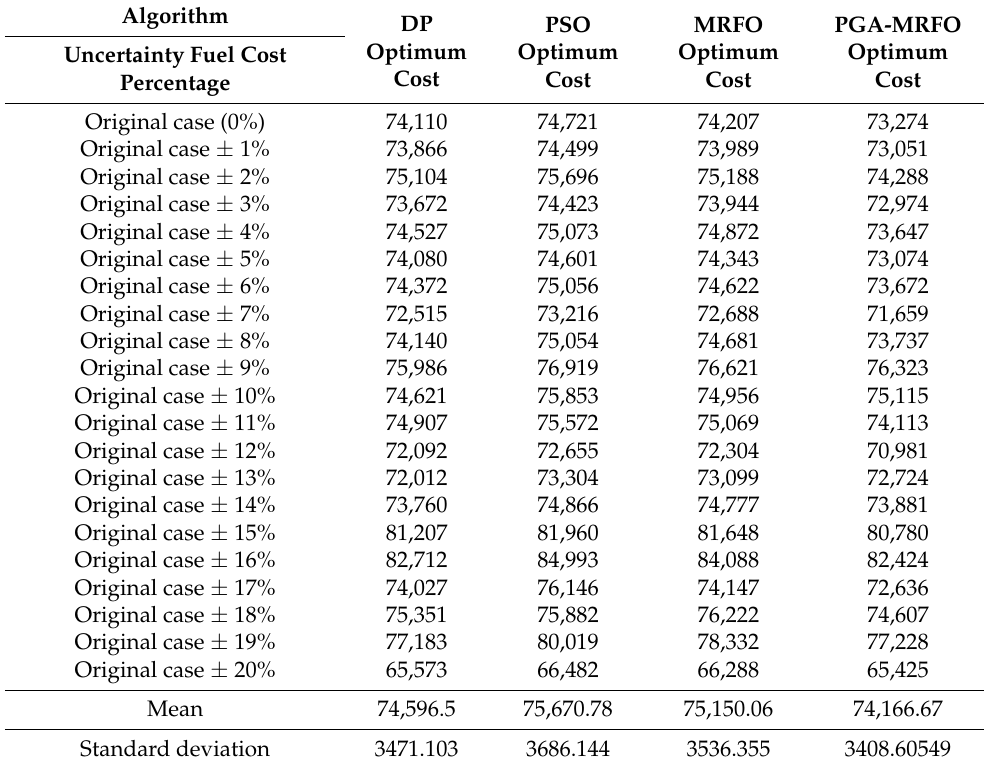
Table 8. Algorithms’ results due to fuel cost